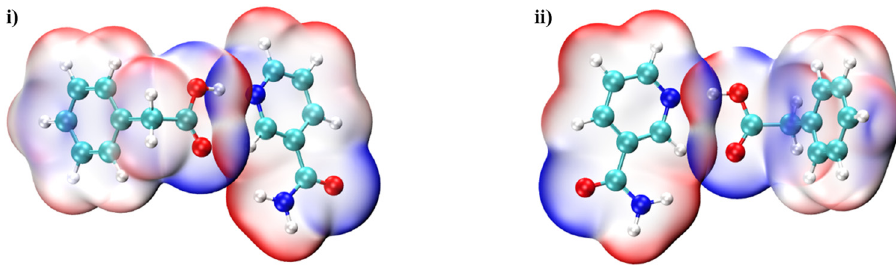
Figure 3: EPS of PN1 : ( i ) front view and ( ii ) opposite view. The blue areas represent negative charges, while the red areas are positively Table 1, the strongest Ei is in pp ( − 75.199 kJ mol − 1 ) , a